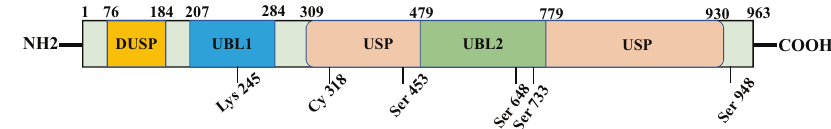
Fig. 2 The structure of USP11. The schematic diagram of amino acid sequence, domain, and critical amino acid